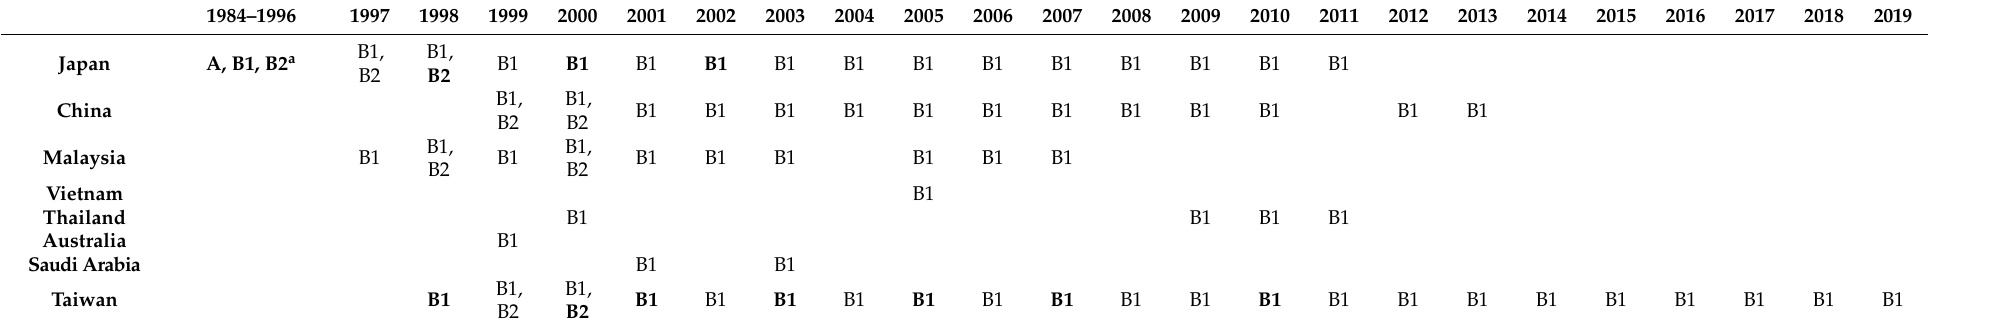
Table 3. The summary of CVA16 genotype based on VP1 region circulated in different countries from 1984 to